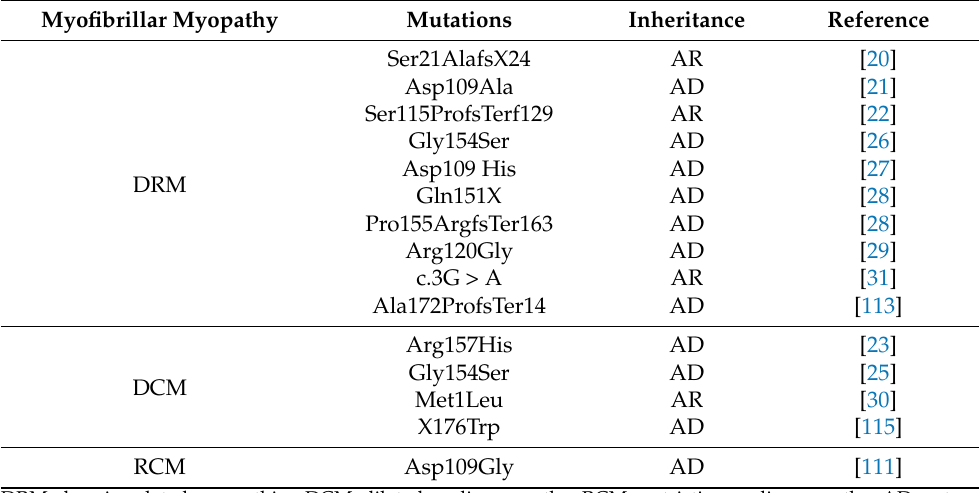
Table 3. Mutations described in HSPB5 gene in pathogenic muscle